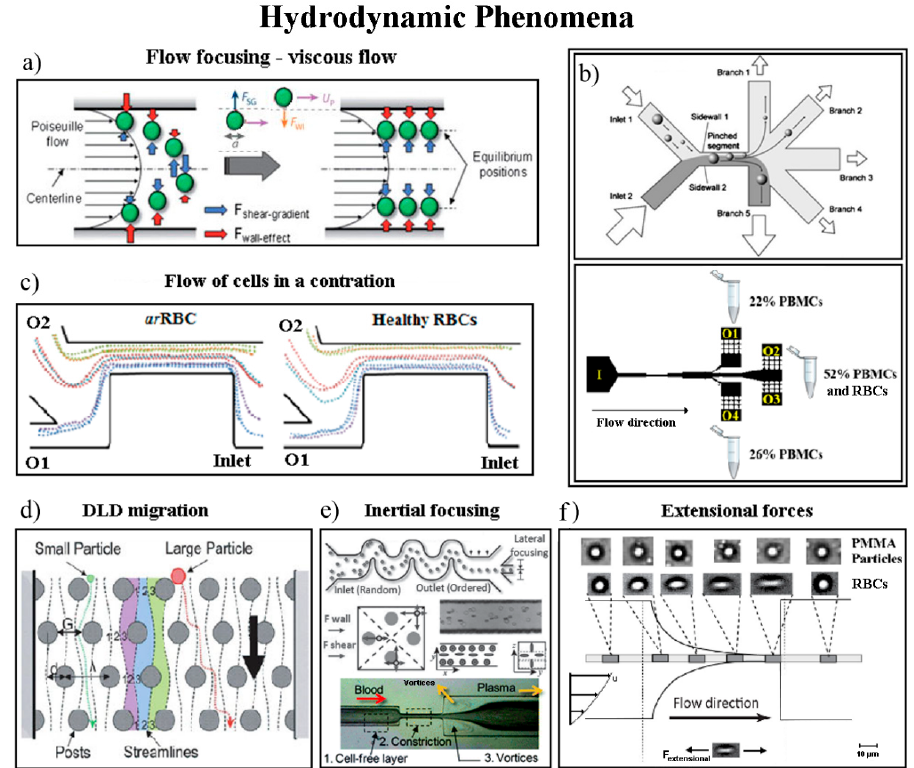
Figure 6. Hydrodynamic methods of separation: ( a ) the implied forces in a Poiseuille flow for cell separation. Reproduced with permission from [86] ( b ) the principle of hydrodynamic filtration in a microchannel with many outlets. Reproduced with permission from [81,84]. ( c ) trajectories analysis of rigid and deformable cells through a contraction for cell separation in two outlets. Reproduced with permission from [87]. ( d ) principle of deterministic lateral displacement. Reproduced with permission from [86]. ( e ) separation using inertial flow forces and at high flow rates creating vortices downstream a contraction. Reproduced with permission from [64,88]. ( f ) extensional forces for cell separation and mechanical analysis. Reproduced with permission from [89].